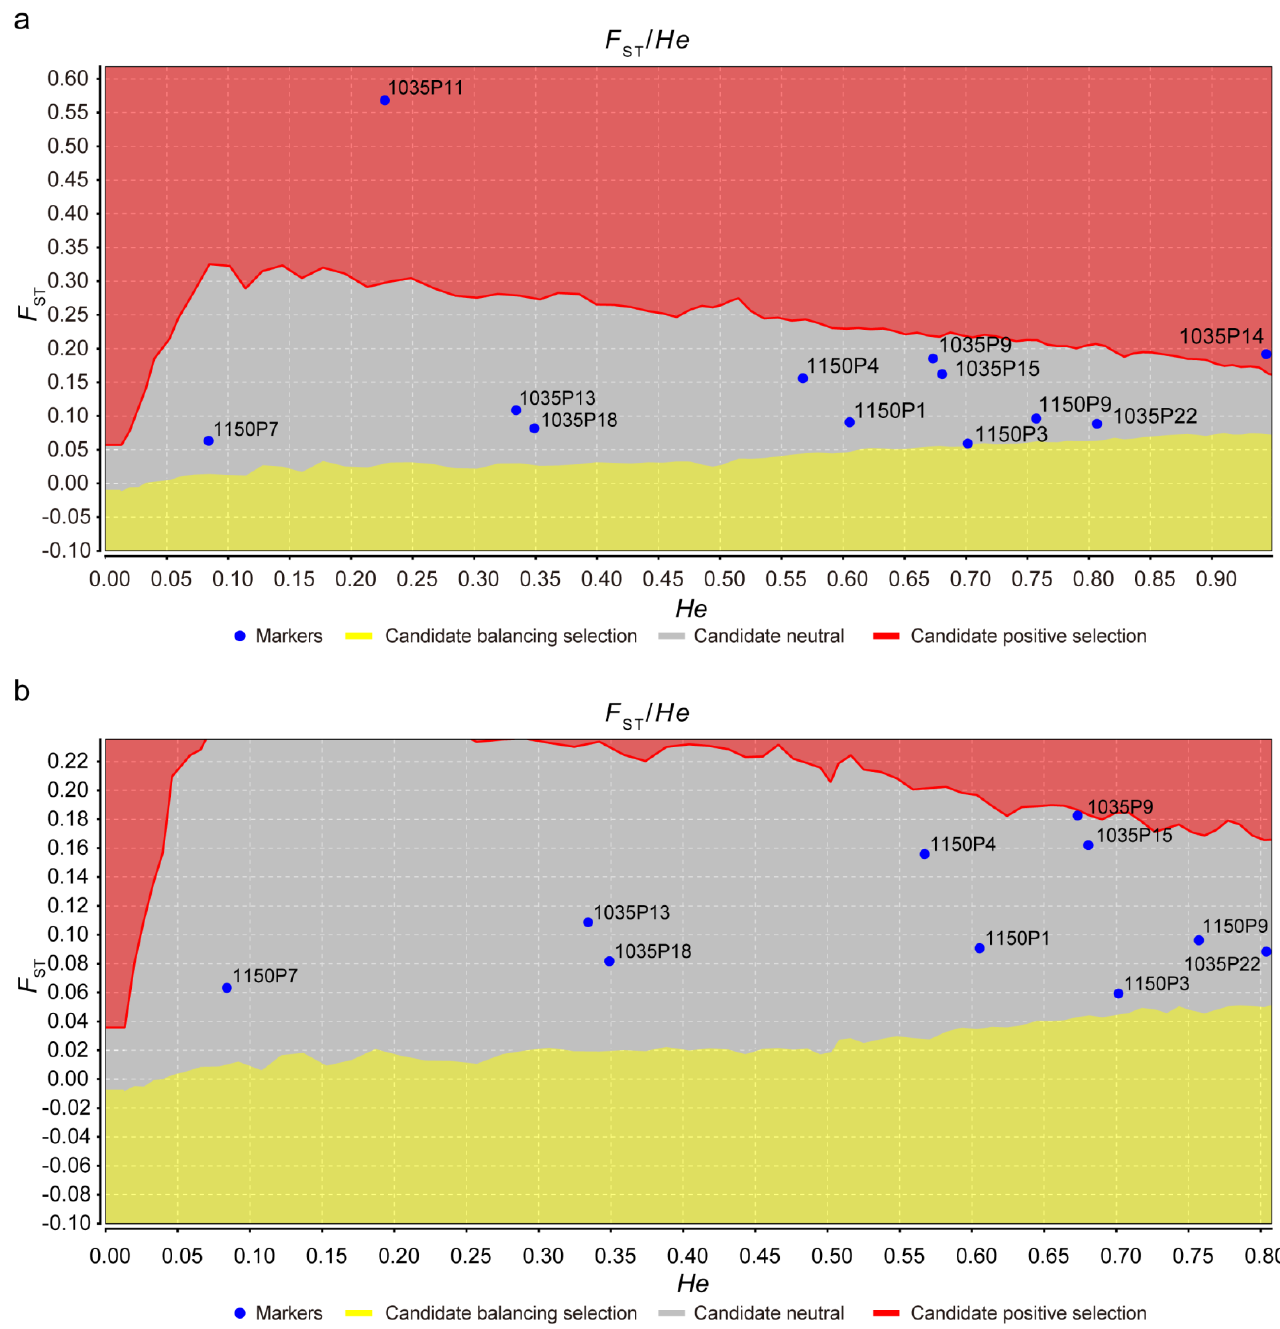
Figure 3. Assessment of F ST outlier EST − SSR loci and neutrality tests. ( a ) analysis of F ST outliers of 12 SSR loci; ( b ) neutrality tests for 10 SSR loci.